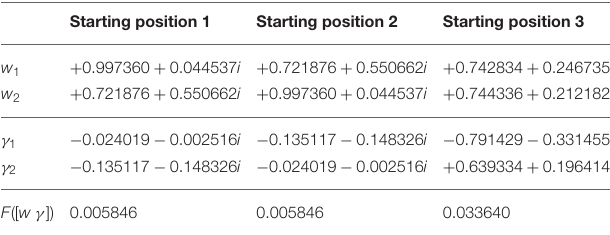
TABLE 1 | Poles, coefficients, and residual levels of the filter functions show in Figure 5 . Starting position 1 Starting position 2 Starting position